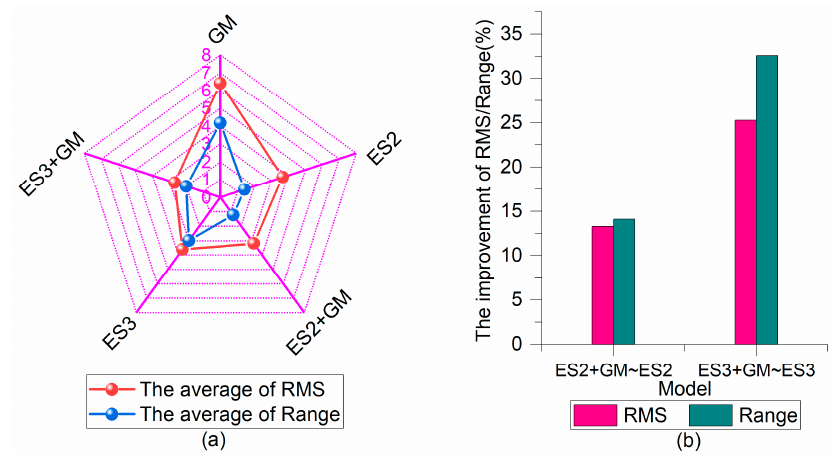
Figure 9. The average accuracy (RMS), stability (Range), and improvement percentage of 6 h forecast using different models: ( a ) is the changes of RMS and Range, and ( b ) is the changes of improvement percentage of RMS and Range. Appl. Sci. 2020 , 9 , x FOR PEER REVIEW